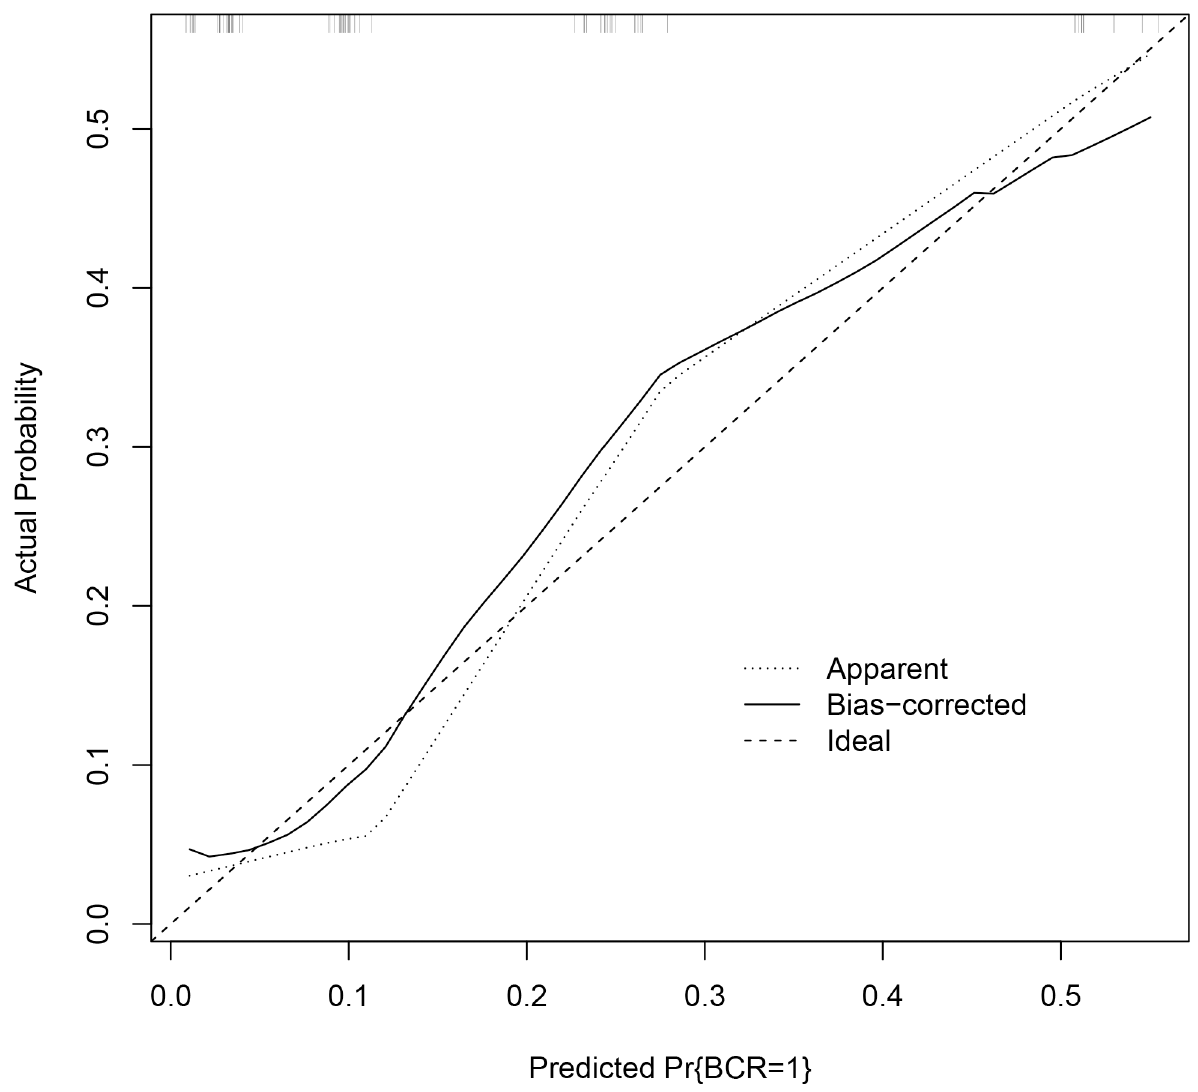
Fig 4. Calibration curve demonstrating performance of predicted probability of 3-year biochemical recurrence versus actual probability noted within the study. BCR = biochemical recurrence.